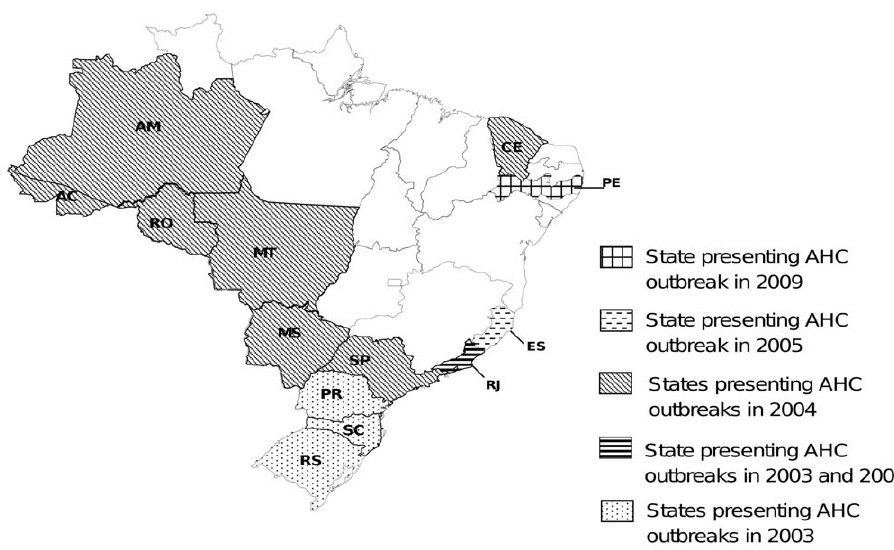
Figure 1. Geographic distribution of CA24v outbreaks in Brazil, 2003–2009.